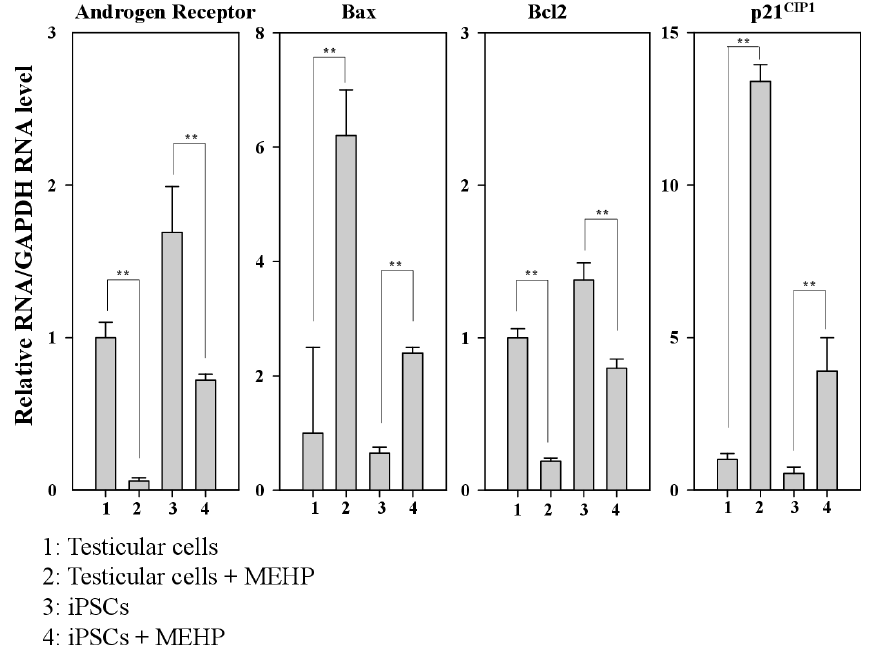
Figure 4. Relative expression of genes related to androgen-receptor-mediated apoptotic signaling. Real-time PCR was performed using the bovine-specific primers listed in Table 2. Relative expression of the genes encoding the AR, BAX, BCL-2 and p21 CIP1 are shown in bovine testicular cells and iPSCs. Values indicated are means ± SEM, n ≥ 3; ** p < 0.01.